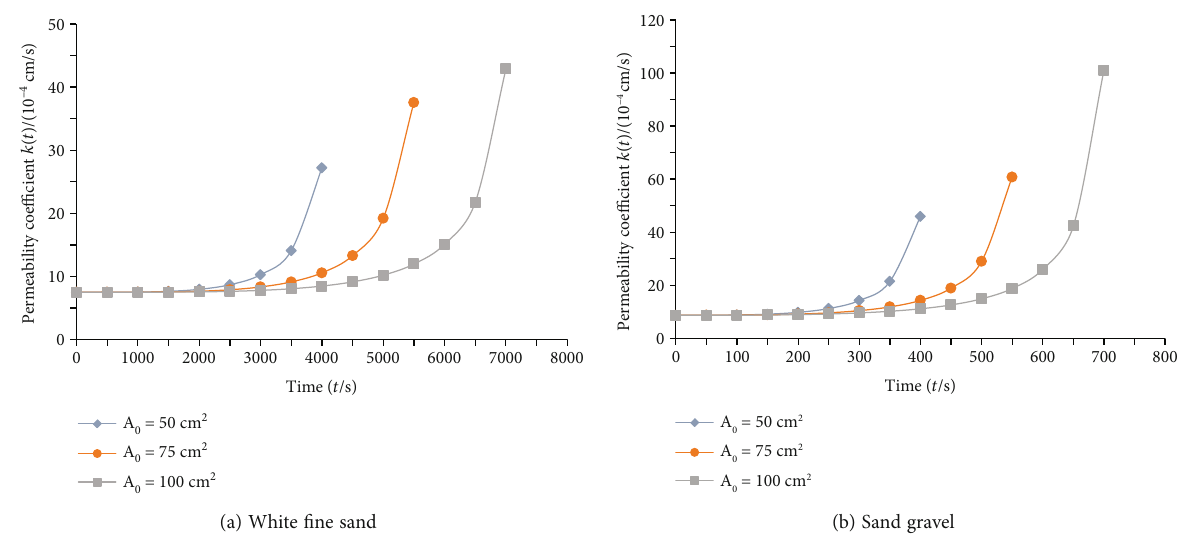
Figure 3: Variation curve between permeability coe ffi cient and time at the free surface of soil with di ff erent A